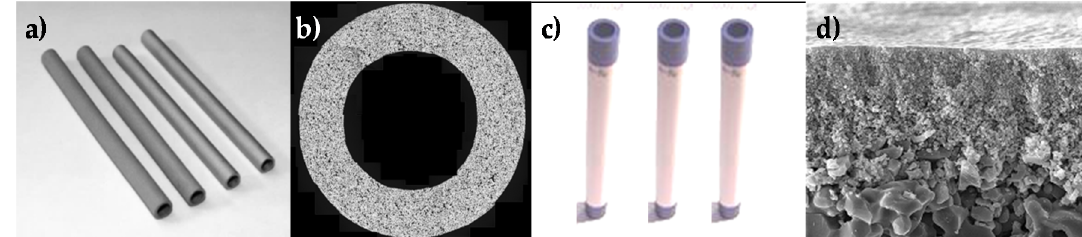
Figure 5. ( a ) Metal porous supports; ( b ) Cross section of a metal porous support; ( c ) Ceramic